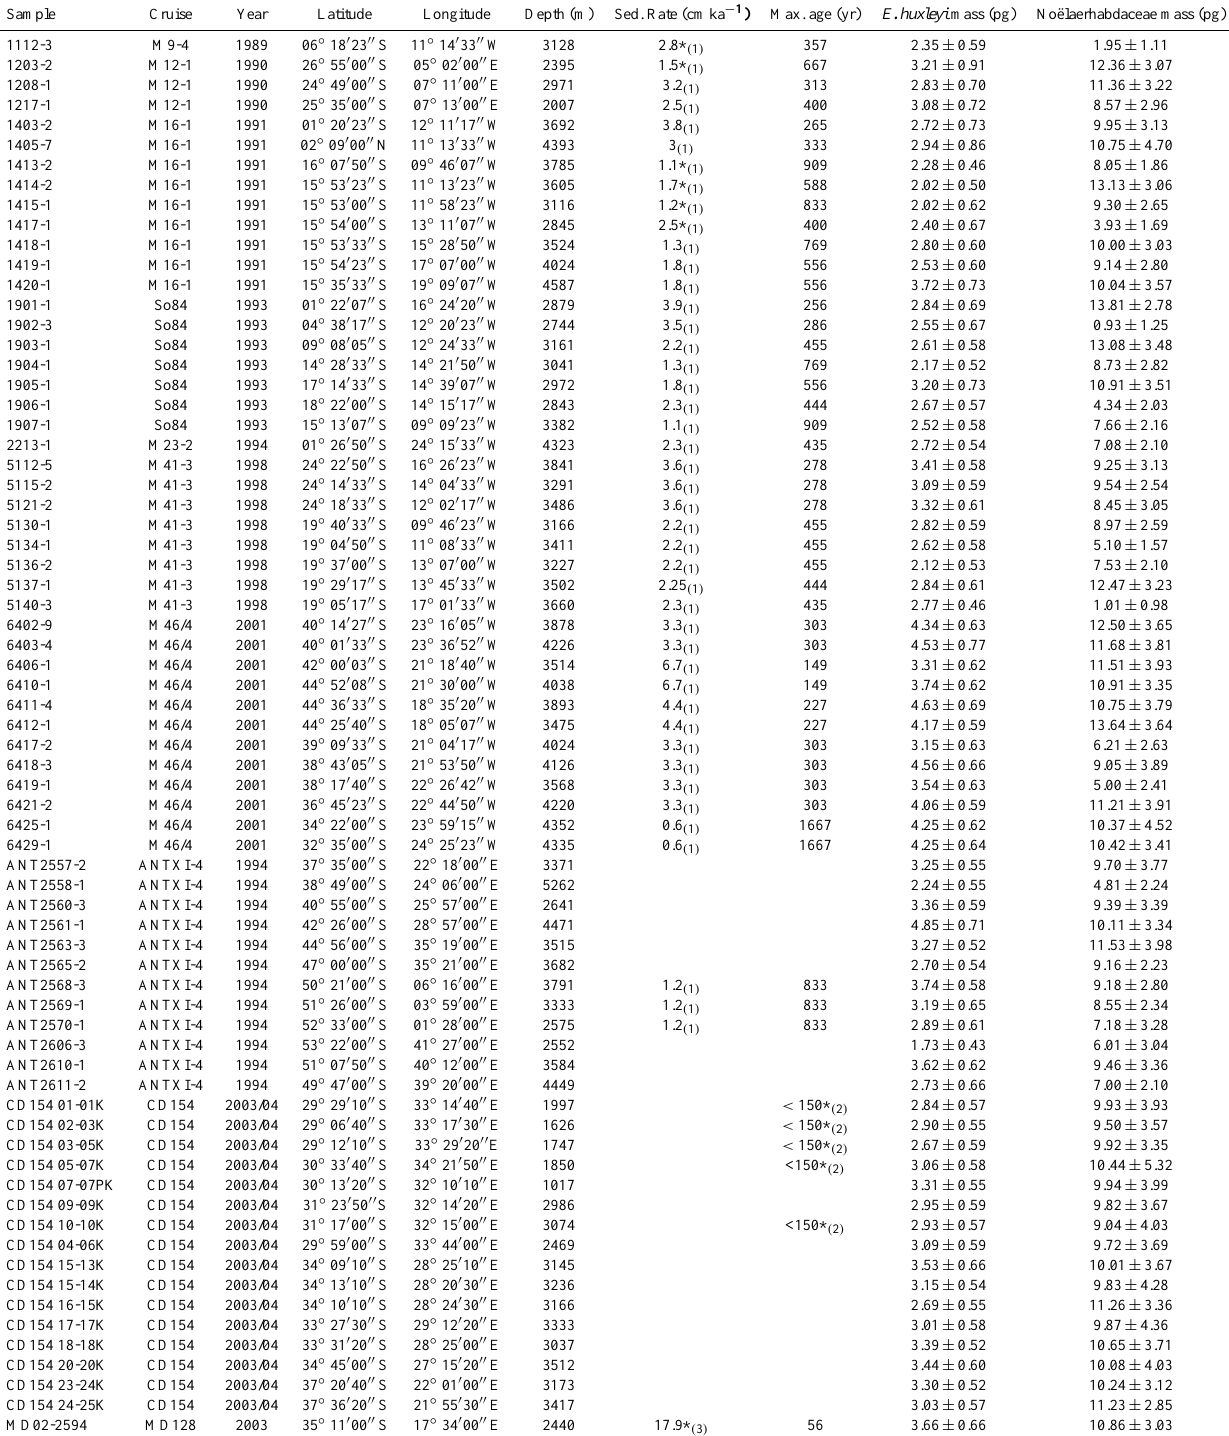
Table 1. Sample information. The sedimentation rates or the maximum age of samples were extracted from (1) Mollenhauer et al. (2004), (2) Jonkers et al. (2012), (3) Martínez-Méndez, et al. (2010). The asterisk (*) shows that the sedimentation rate was calculated for that specific core, otherwise it has been estimated from sedimentation rates calculated for nearby